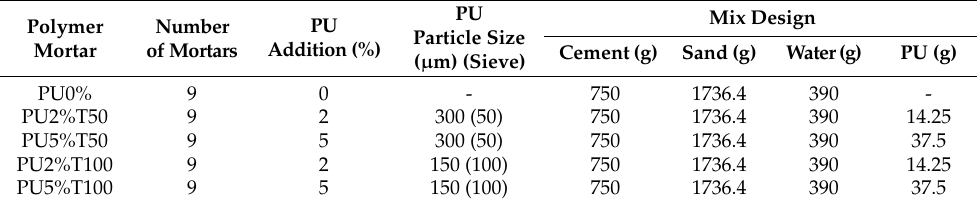
Table 3. Mix design used for polymer mortar